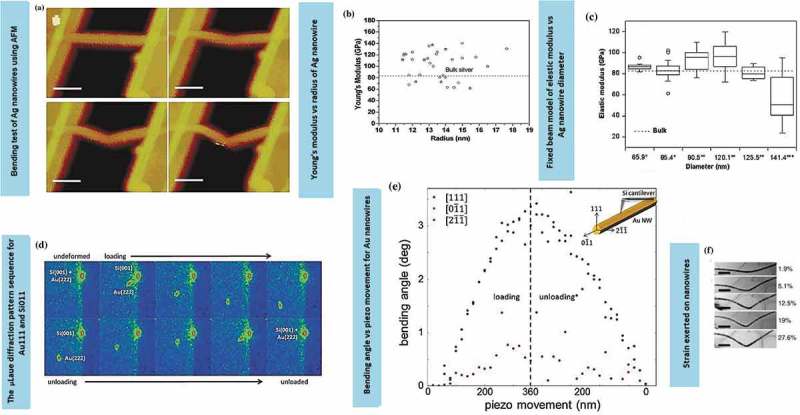
(a) The AFM images of a 23.6 nm Ag nanowire under the tapping mode test before and after the brittle failure occurred with the scale bar of 250 nm [241]. (b) The Young’s modulus plot as a function of Ag nanowire radius. The modulus remains the same before (circle) and after (star) the thermal annealing process [241]. (c) The plot of the elastic modulus vs diameter of the Ag nanowires with the nanowire diameter assigned from the fixed beam model (*), simple beam model (**) and simple fixed beam model (***) [242]. (d) In situ micro-diffraction pattern sequence for the Au 111 and Si 011 Laue spots evolution during the bending test [243] with (e) the bending angle plot as a function of the AFM cantilever movement [243]. (f) The snapshots of strain exerted on the nanowires [248]. (Adapted with permission from [241] copyright (2006) American Chemical Society, reproduced from [242] with permission by AIP Publishing LLC, adapted with permission from [243] under the terms of the Creative Commons Attribution Licence and adapted from [248] with permission from Nature Publishing Group).